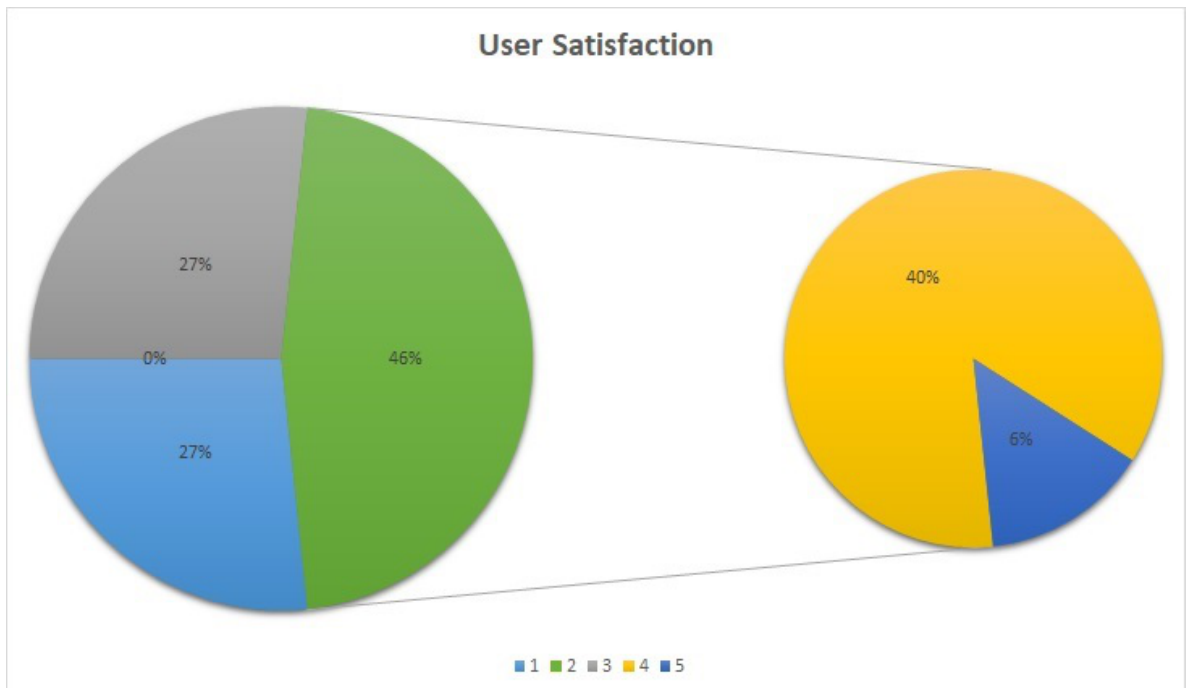
Figure 7. The pie chart reports the distribution of user satisfaction investigated through question Q5 in the case of the robot providing critical help to the